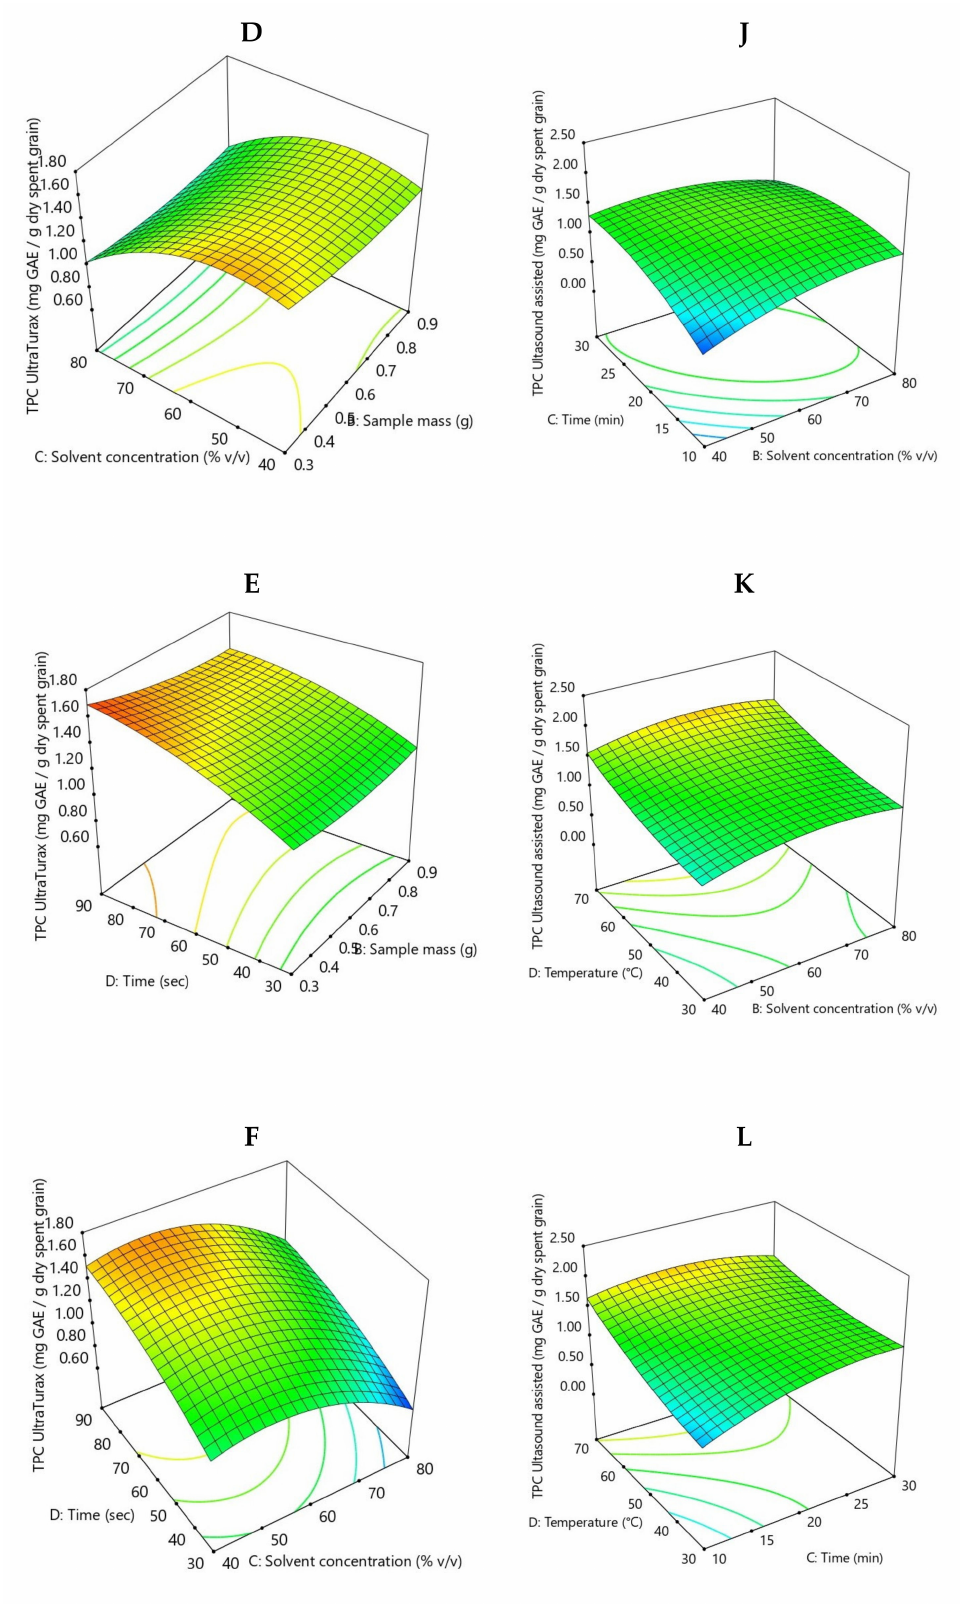
Figure 2. Response surface plots showing the effect of extraction parameters on phenolic compounds for SG Ultra-Turrax pre-treatment ( A – F ), and for ultrasound-assisted pre-treatment ( G – L